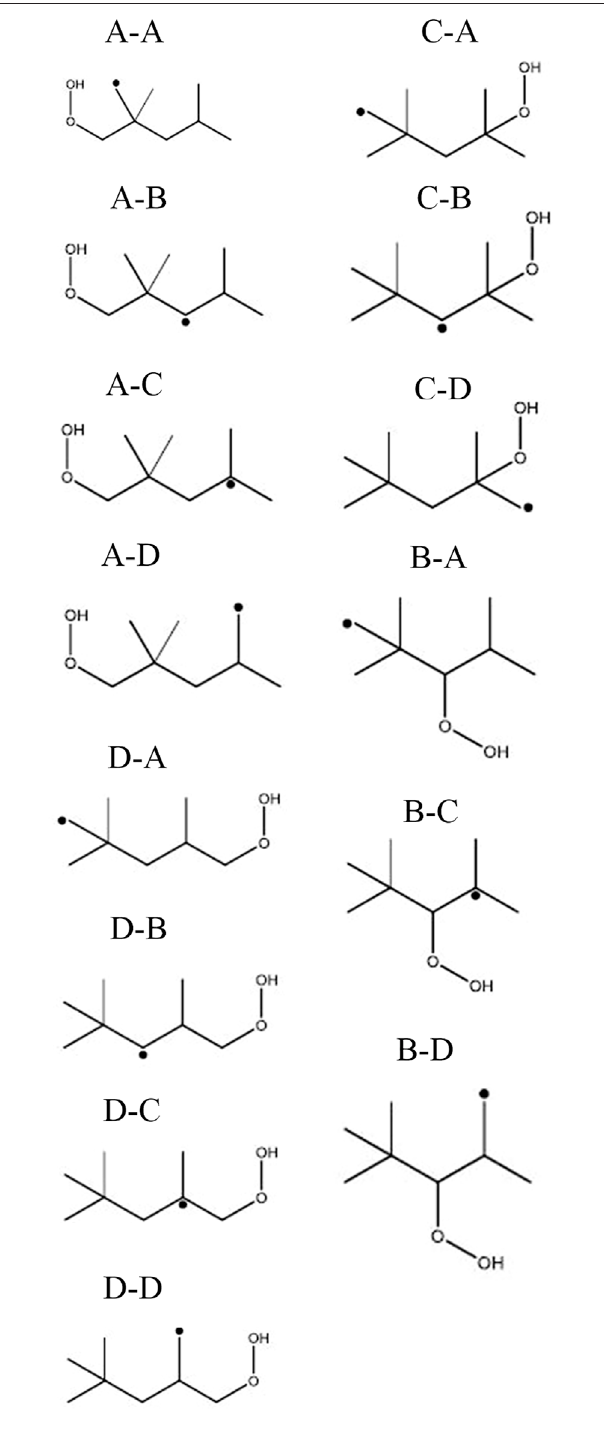
FIGURE 9 | Species dictionary of QOOH